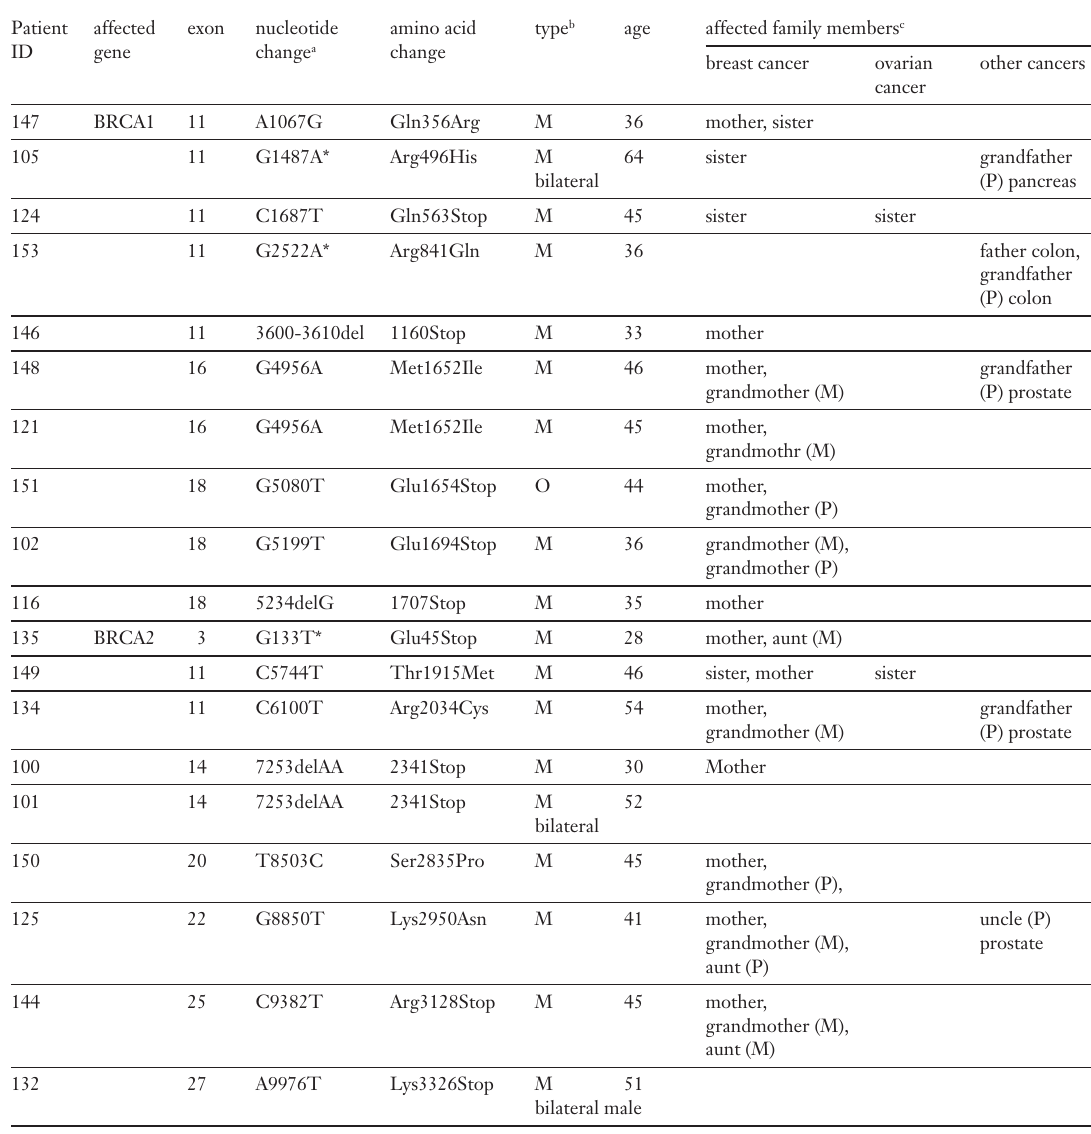
Table 3 Definition of the indi- vidual 17 mutations found in 19 Swiss